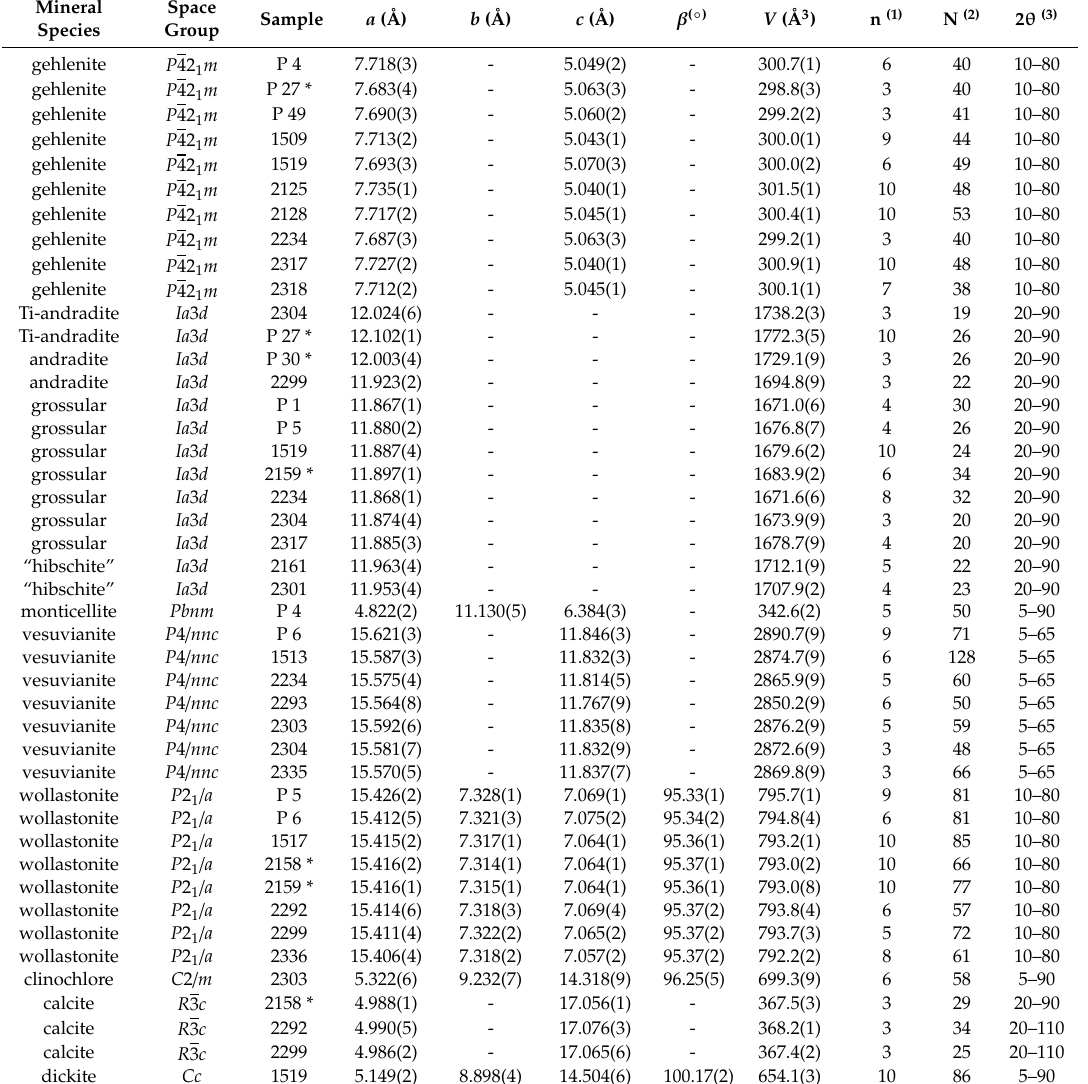
Table 1. Crystallographic parameters of selected minerals in the M ă gureaua Va¸tei